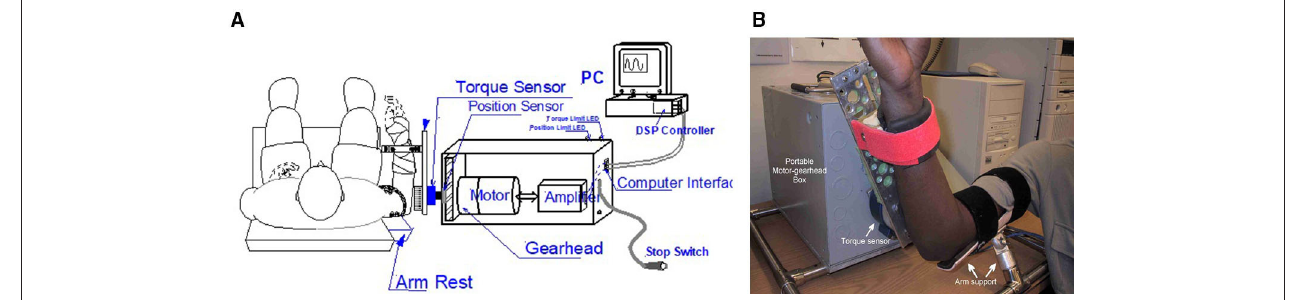
FIGURE 2 | (A) The intelligent stretching device designed to stretch the elbow joint with spasticity and evaluate treatment outcome with multiple neuromechanical outcome measures. A digital signal processor (DSP) controller constantly adjusts the stretching velocity based on the resistance, and it checks the joint position and torque signals at 2,000Hz and shuts down the system if they are out of pre-specified ranges. The torque limit and position limit light-emitted diodes (LEDs) indicate whether a resistance torque limit or position limit (safety limits) is reached, respectively, during the stretching. (B) Shows the position of the subject during the stretching.